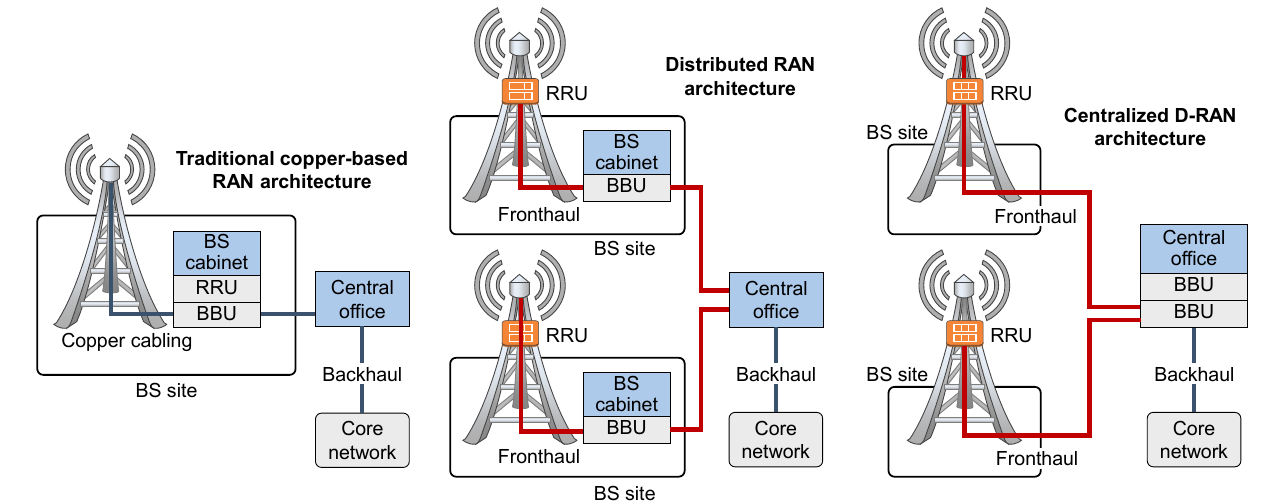
Figure 1. Comparison of traditional RAN and D-RAN architecture.